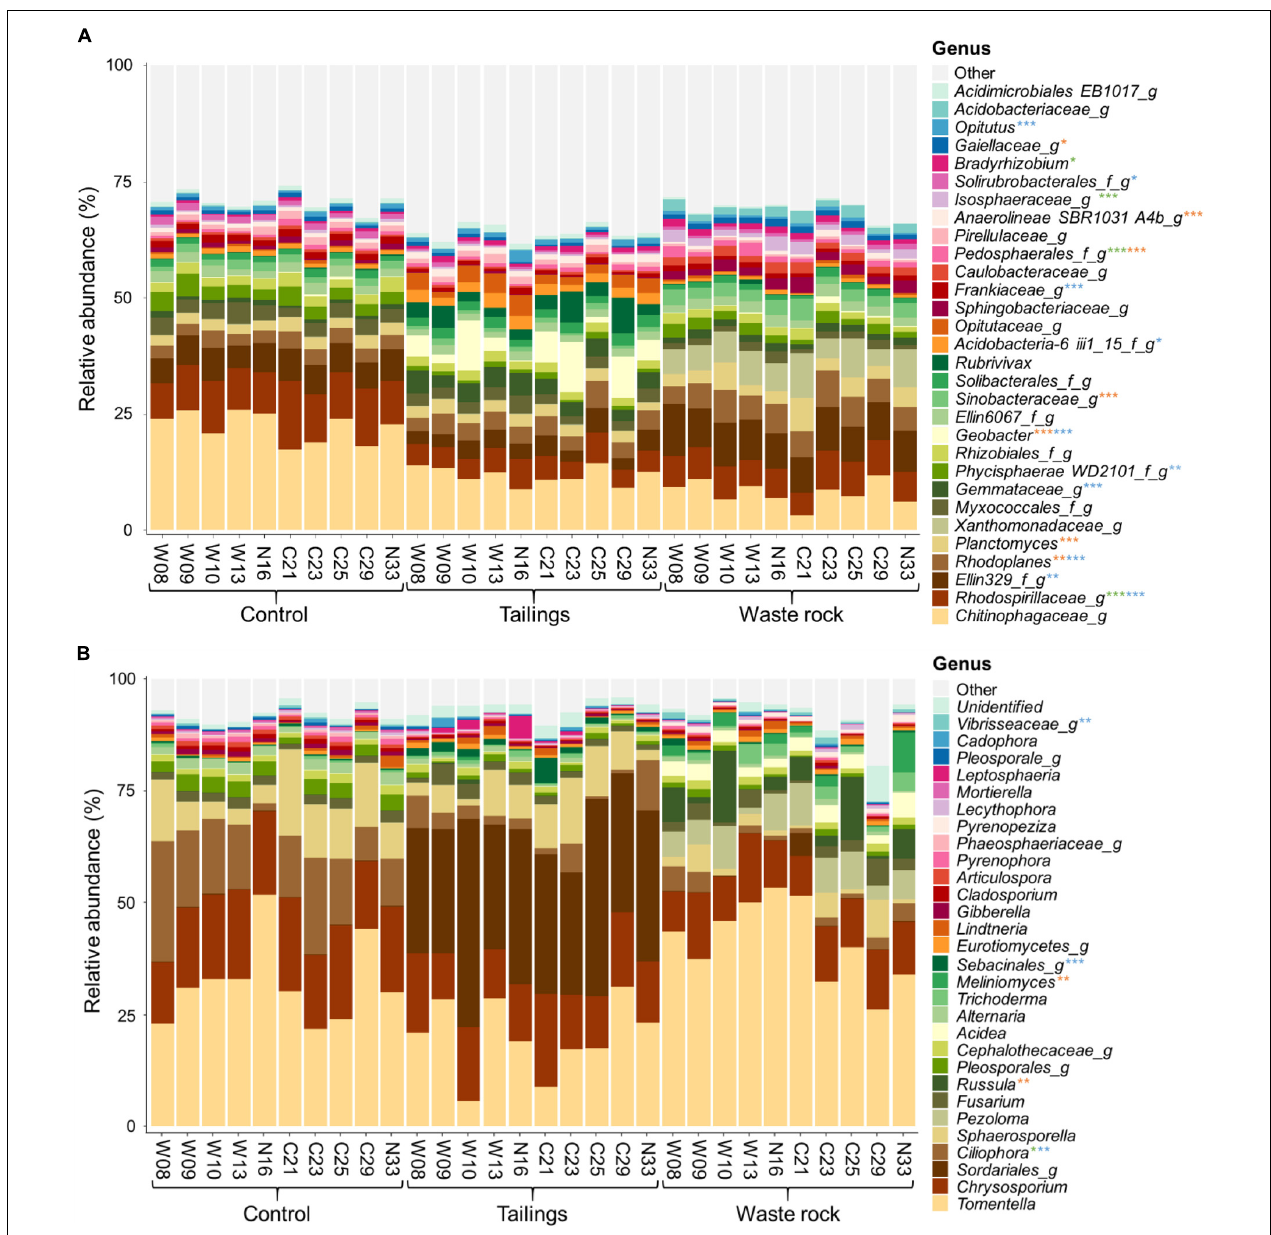
FIGURE 6 | Taxonomic profiles of bacterial and fungal communities in treatments from the greenhouse experiment. Bacterial (A) and fungal (B) communities at the genus level. Only bacterial and fungal taxa with a relative abundance > 1% in at least one treatment are shown. Replicates for each genotype were pooled for visual simplification ( n ≥ 3). Stars represent levels of significant difference between genotypes in the three substrates analyzed separately: green for control, blue for tailings and orange for waste rock. Significant differences were determined by a Tukey HSD post hoc pairwise comparison test. Significance level is represented as follows: p < 0.001 ***, p < 0.01 **, p < 0.05 *.